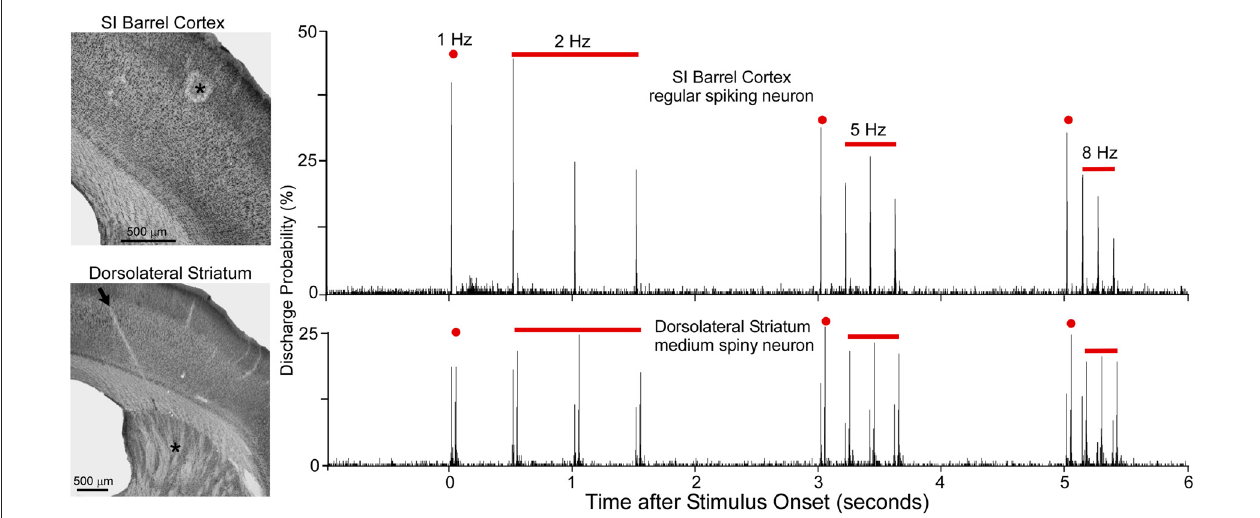
FIGURE 5 | Neuronal responses recorded simultaneously in primary somatosensory cortex (SI; top) and DLS (bottom) during computer-controlled whisker deflections administered at 2, 5 and 8-Hz. Nearly two dozen whiskers were deflected in tandem in which each deflection consisted of back-and-forth movements in a 50-ms period. Photomicrographs illustrate the recording sites (asterisks) in SI and DLS. Peristimulus time histograms show that SI neurons adapt rapidly to repetitive whisker movements whereas DLS neurons adapt slowly. First deflection in each epoch is classified as 1-Hz because it is separated from previous deflections by at least 1 s. Adapted from Mowery et al. (2011).